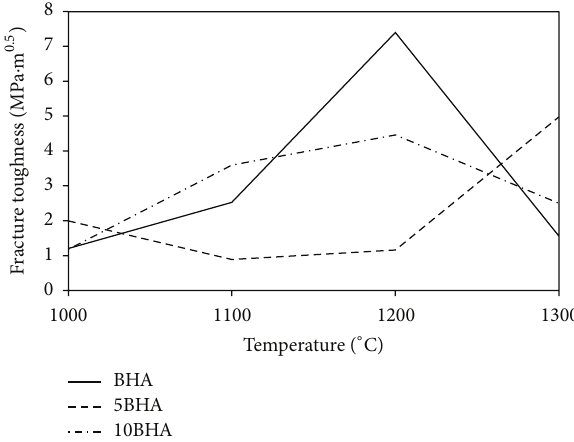
Figure 11: Variation of toughness of BHA, 5BHA, and 10BHA composites at different sintering temperature.